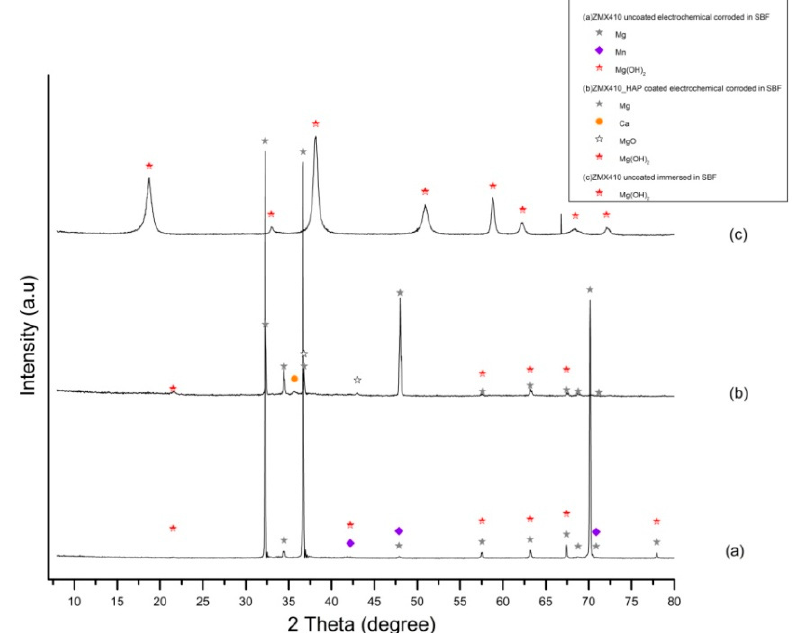
Figure 18. XRD patterns of uncoated ZM410 alloy after electrochemical corrosion ( a ), HAP coated ZM410 alloy after electrochemical corrosion ( b ) and uncoated ZM410 alloy after immersion corrosion in SBF ( c ) (bullets indicate the peaks corresponding to diffraction angles of the main phases).